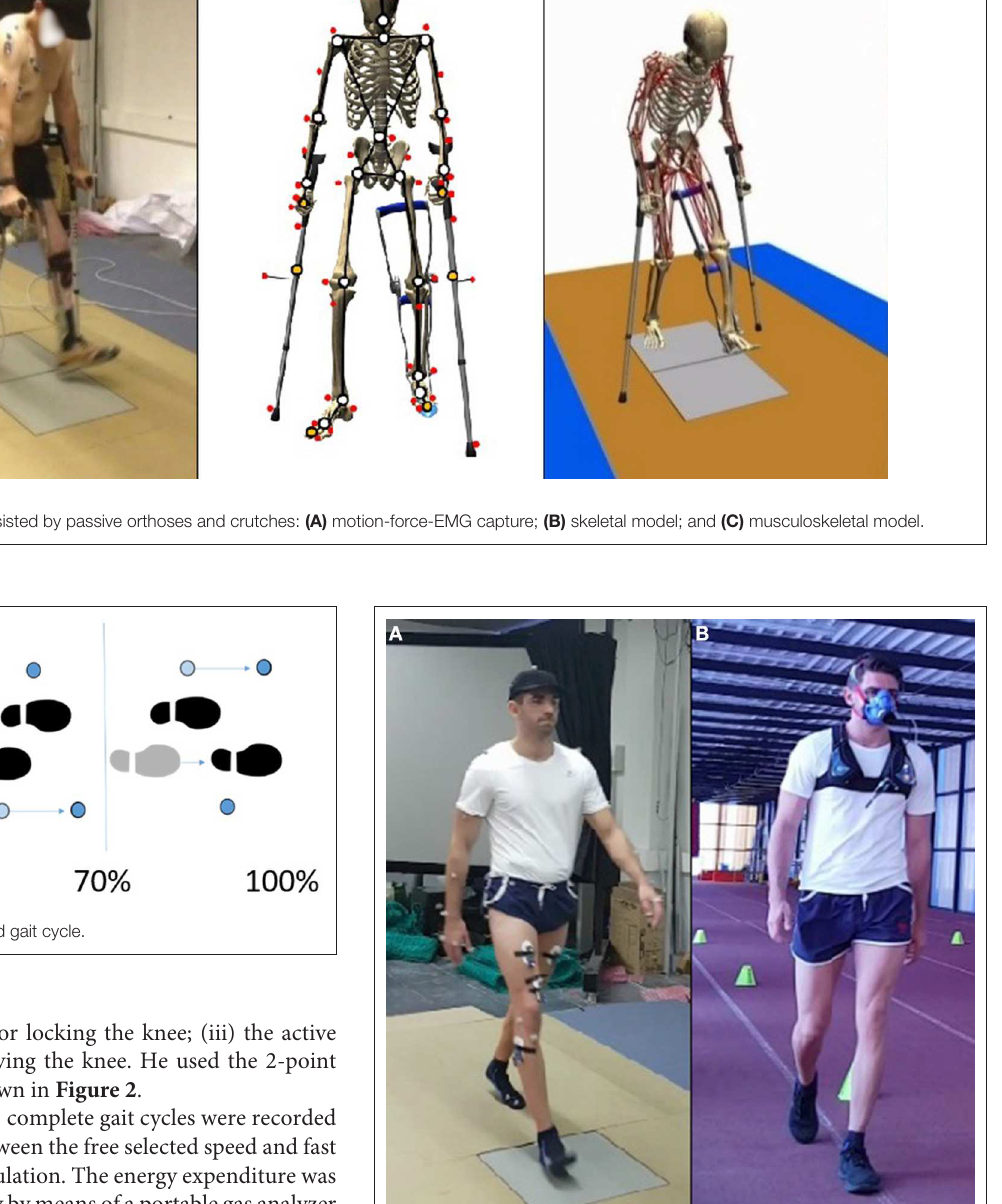
forefeet, shanks, thighs, arms, forearms and hands. For the SCI subject ( Figure 1B ), the same model was used, but the hands were rigidly connected to the crutches, and the orthosis at the left leg was embedded in the corresponding body links (thigh,